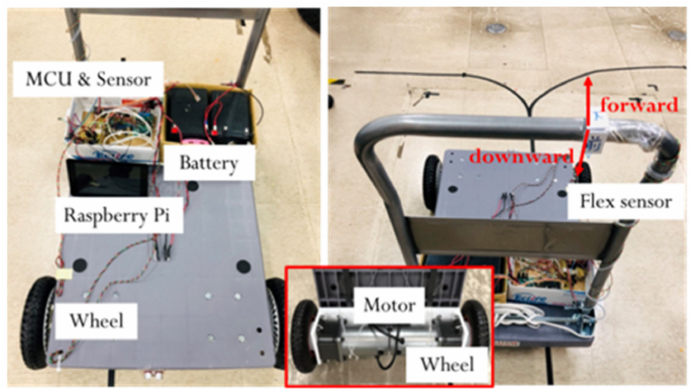
Figure 2. Real design of the proposed smart